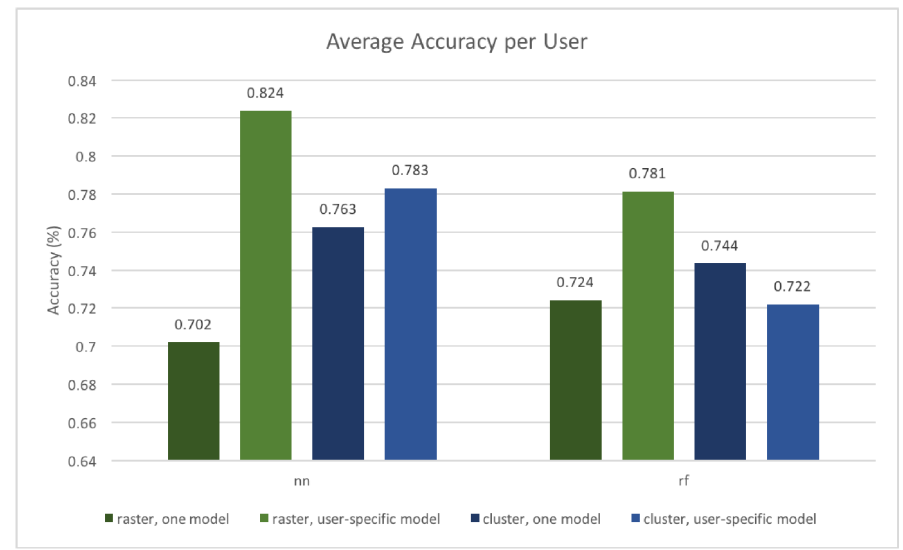
Figure 9. The average accuracy depending on the model and input time. The user-specific models are solely trained on data from one user, while the other models take into account data from all